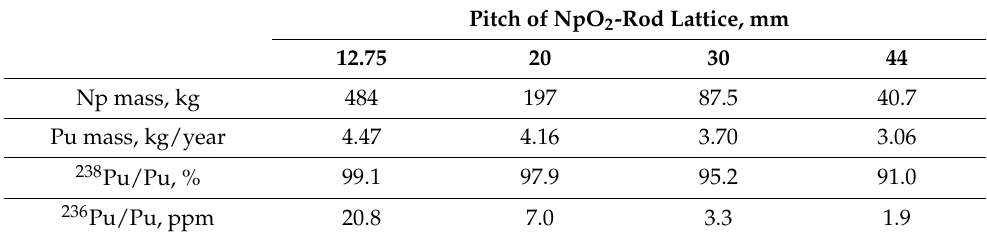
Table 5. Plutonium production rate and plutonium isotope composition caused by elongated pitch of NpO 2 -rod lattice (the encirclement by 208 Pb-FAs).